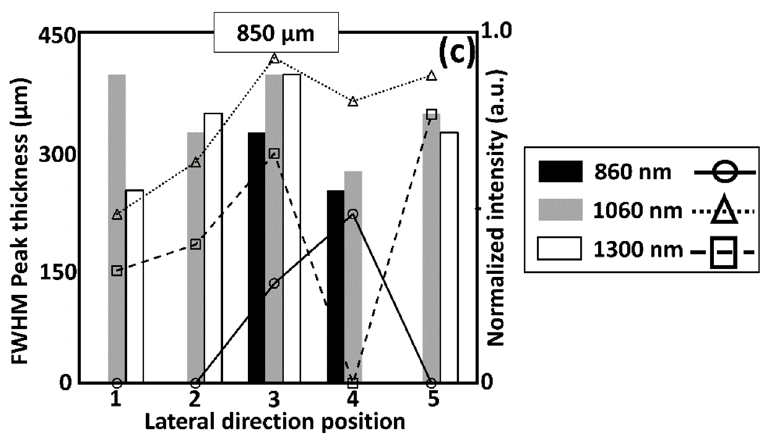
Figure 8. The numerical quantifications for thickness and normalized intensity correspond to intra-cochlear microstructural positions (indicated by 5 uniform points) in each wavelength range of Figure 7. ( a ) FWHM thickness and the normalized intensity values correspond to five lateral direction positions of all three OCT systems selected from 300 µ m depth range; ( b ) FWHM thickness and the normalized intensity values correspond to five lateral direction positions of all three OCT systems selected from 700 µ m depth range; ( c ) FWHM thickness and the normalized intensity values correspond to five lateral direction positions of all three OCT systems selected from 850 µ m depth range.